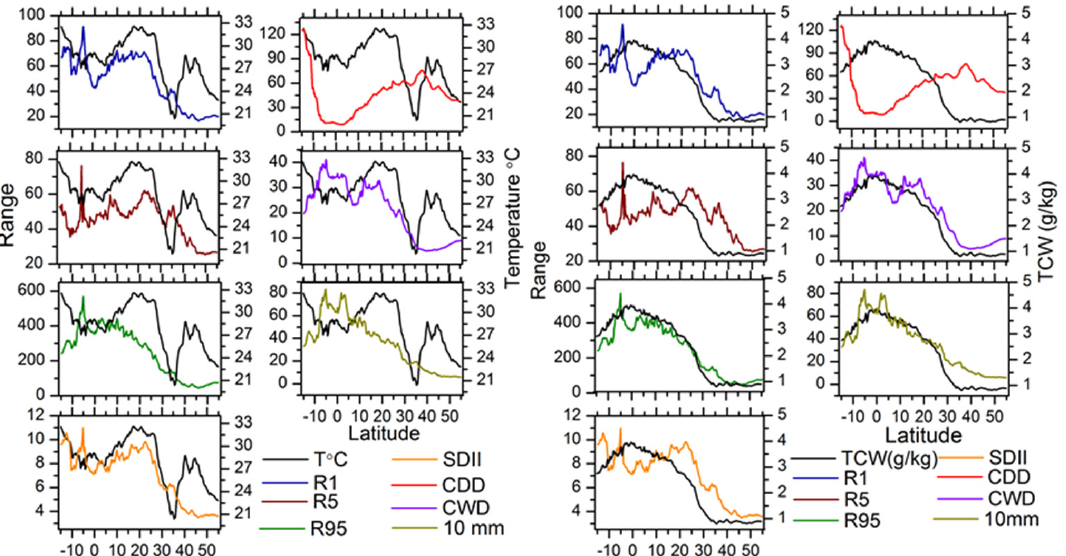
Figure 5. The variation in extreme precipitation climate change indices and surface temperature (T °C) and TCW (g/kg) over MA. For each sub-figure, the left Y-axis scale represents the scale for precipitation climate change indices and the right Y-axis scale represents the scale for T and TCW.